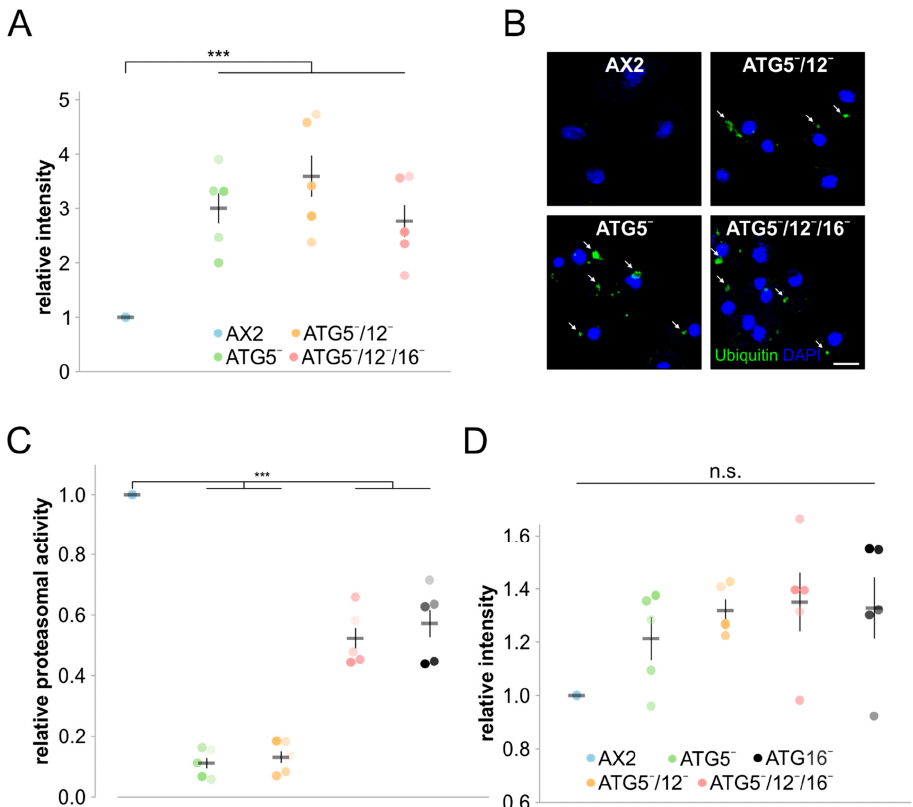
Figure 7. Protein homeostasis is disturbed. ( A ) Quantification of global protein ubiquitination of AX2, ATG5¯, ATG5¯/12¯, and ATG5¯/12¯/16¯ cells. Western blots of total cell lysates were stained with mAb P4D1 and signal intensities of ubiquitinated proteins were quantitated and normalised with the actin signal. The signal intensity of AX2 was set to 1. Mean values and SEM of five independent experiments are shown. ( B ) Immunofluorescence microscopy of AX2, ATG5¯, ATG5¯/12¯, and ATG5¯/12¯/16¯ cells. Cells were fixed with cold methanol and stained with the mAb P4D1. Ubiquitin-positive protein aggregates in mutant strains are marked by arrows. Nuclei were visualised by DAPI staining. Scale bar, 5 µm. ( C ) Proteasomal activity of AX2, ATG5¯, ATG5¯/12¯, ATG5¯/12¯/16¯, and ATG16¯ cells. The assay was performed as described [39]. The chymotrypsin-like activity of AX2 was set to 1. Color assignment of strains is as in panel D. Mean values and SEM of five independent